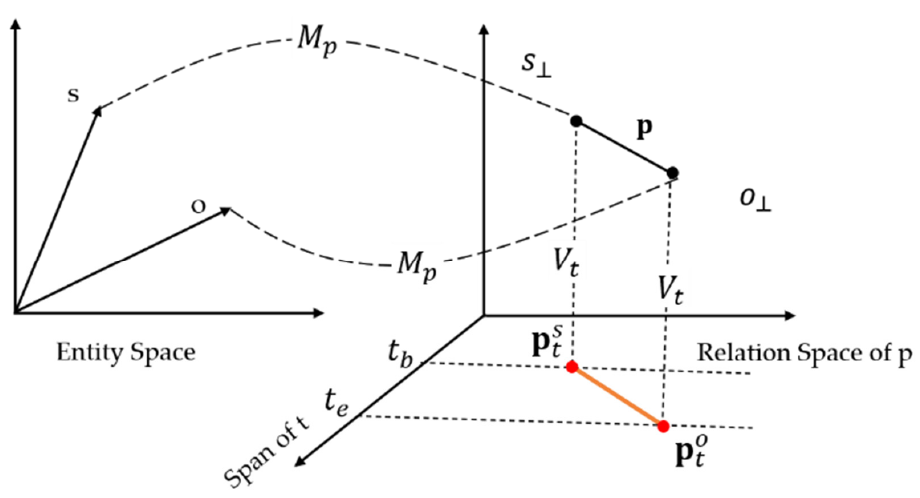
Figure 4. The overall structure of the TBRm model.